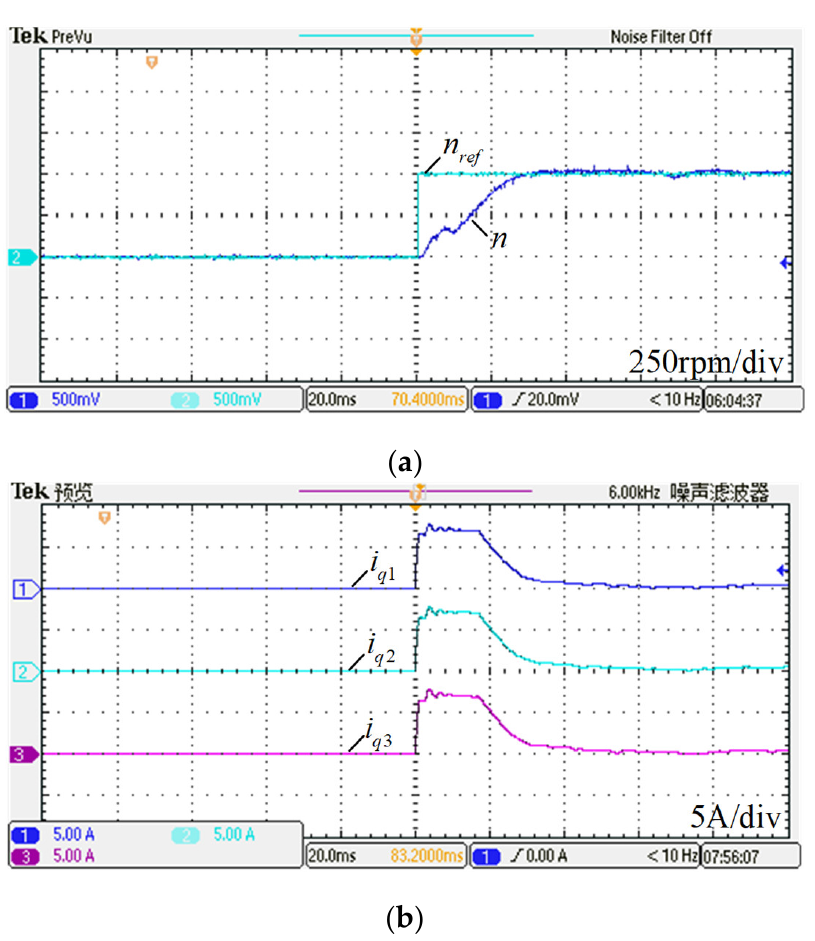
Figure 6. Step response of given speed, ( a ) speed: Channel 1: actual speed, Channel 2: reference speed (250 rpm/div), Horizontal: Time (0.02 s/div); ( b ) q-axis currents: Channel 1: q1, Channel 2: q2, Channel 3: q3, (5A/div), Horizontal: Time (0.02 s/div). (PS: “预览” means preview, “噪声滤波器” means Noise Filter).